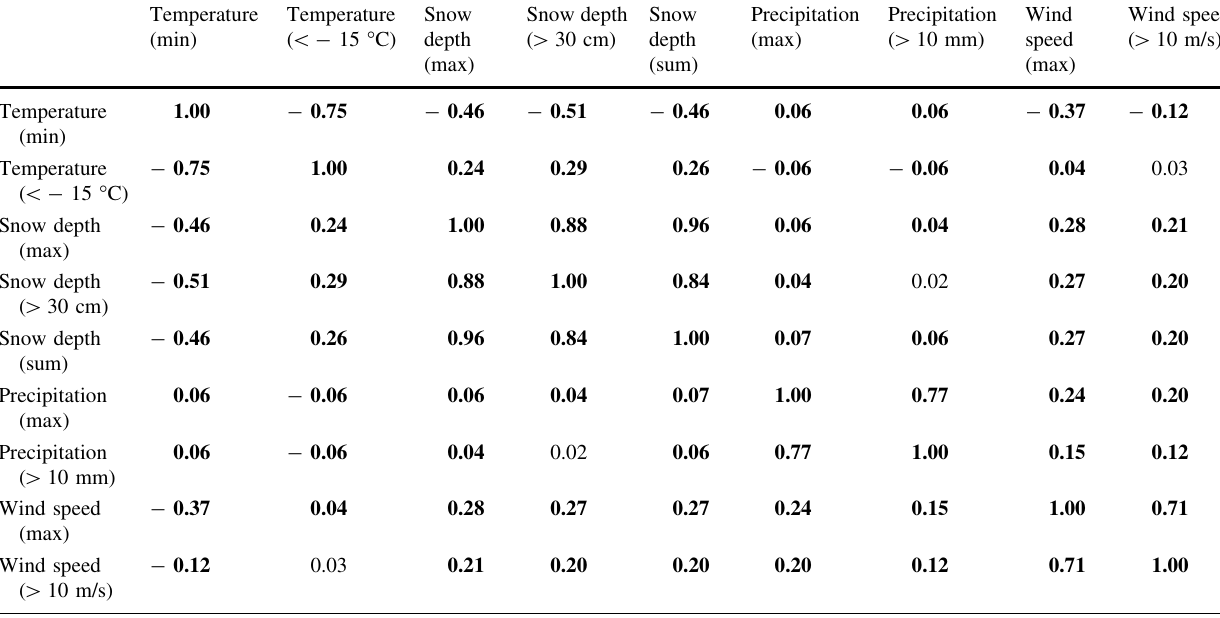
Table 2 Pearson product-moment correlation coefficients (Pearson’s r ) between assumed drivers of low